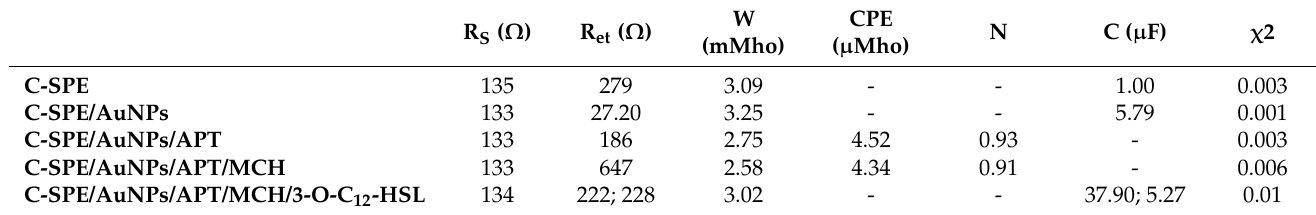
Table 3. Values of circuit elements obtained by fitting the experimental data obtained for each